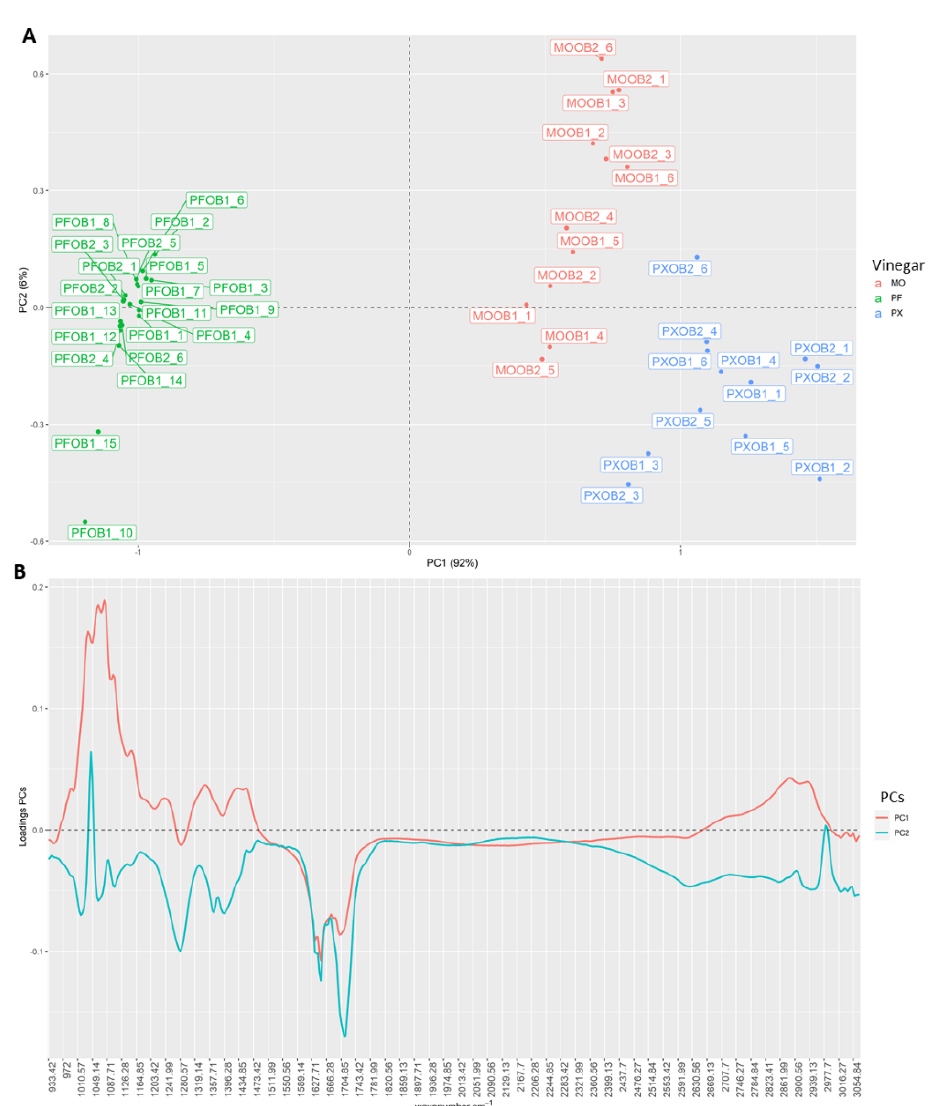
Figure 2. ( A ) Scores obtained by all the samples for the first two principal components (PC1 and PC2); ( B ) loadings obtained in each of the PCs .